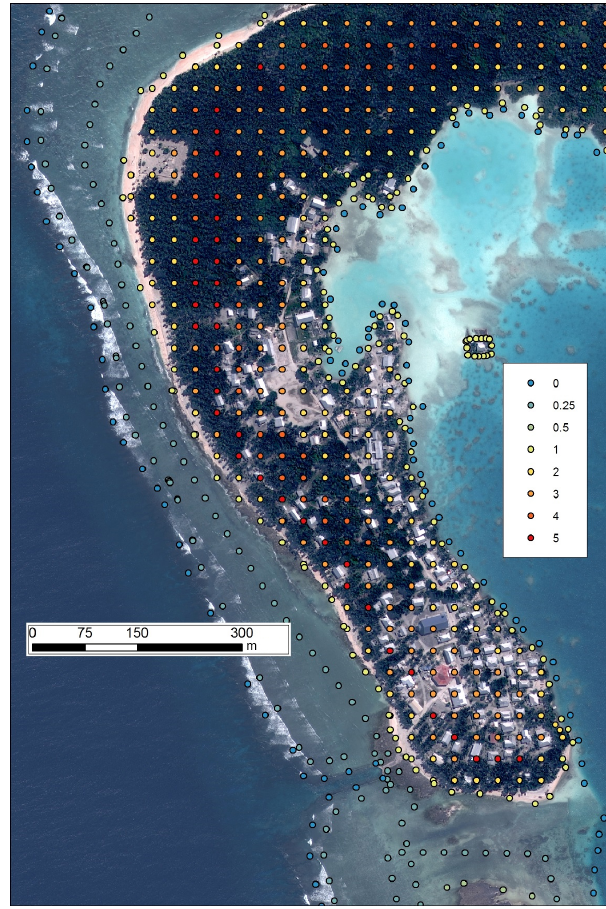
Figure 2. Example of derived spot-height data (in metres) with a grid spacing of ∼ 30m for a selected area around Atafu village. These new elevation (depth) data are used in the tsunami simula- tions.